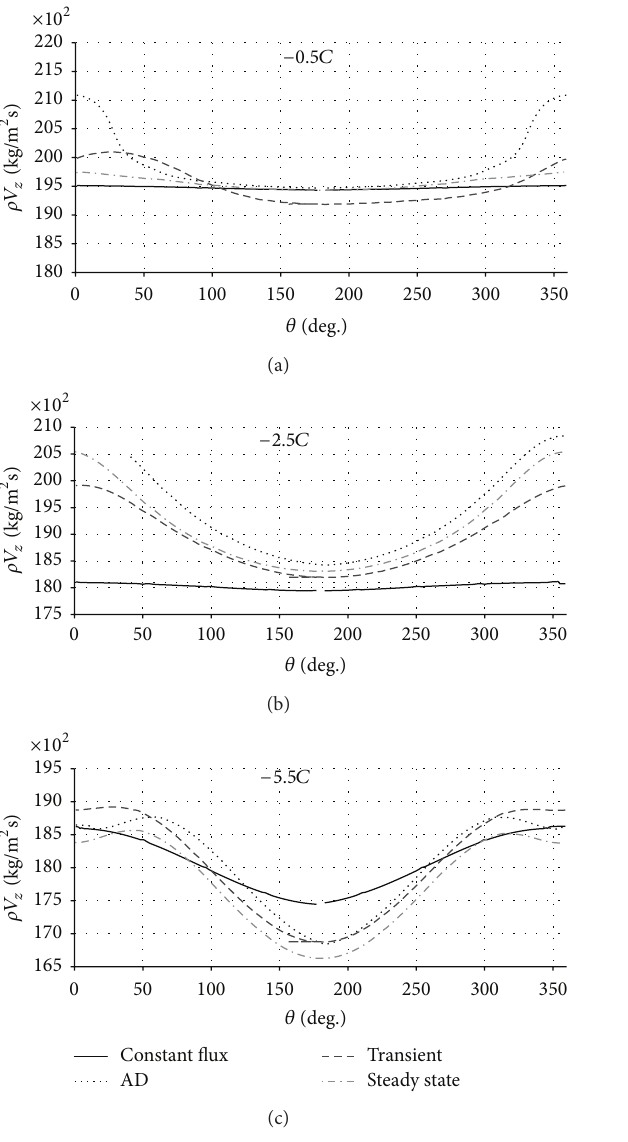
Figure 22: Comparison of unit mass flow rate of the first reference line.